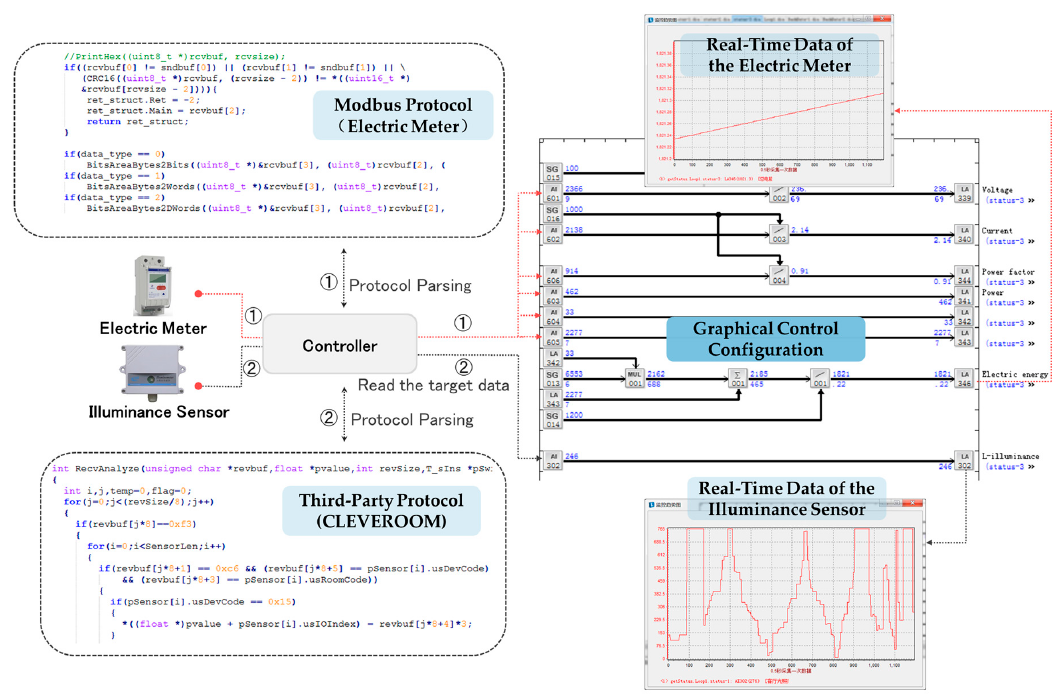
Figure 13. An example of monitoring heterogeneous sensors.